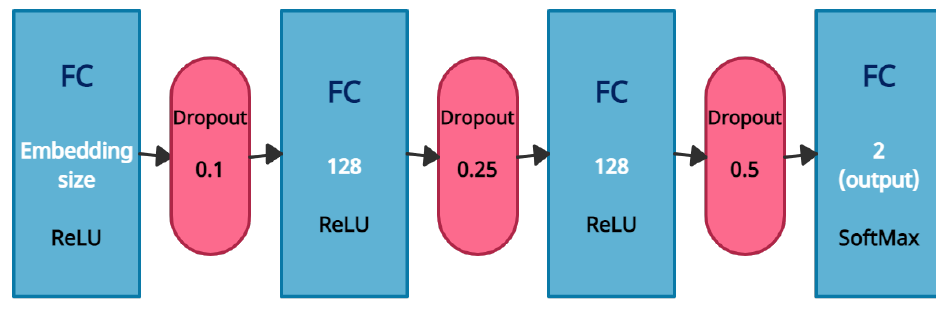
Figure 3. An Illustration of MNA